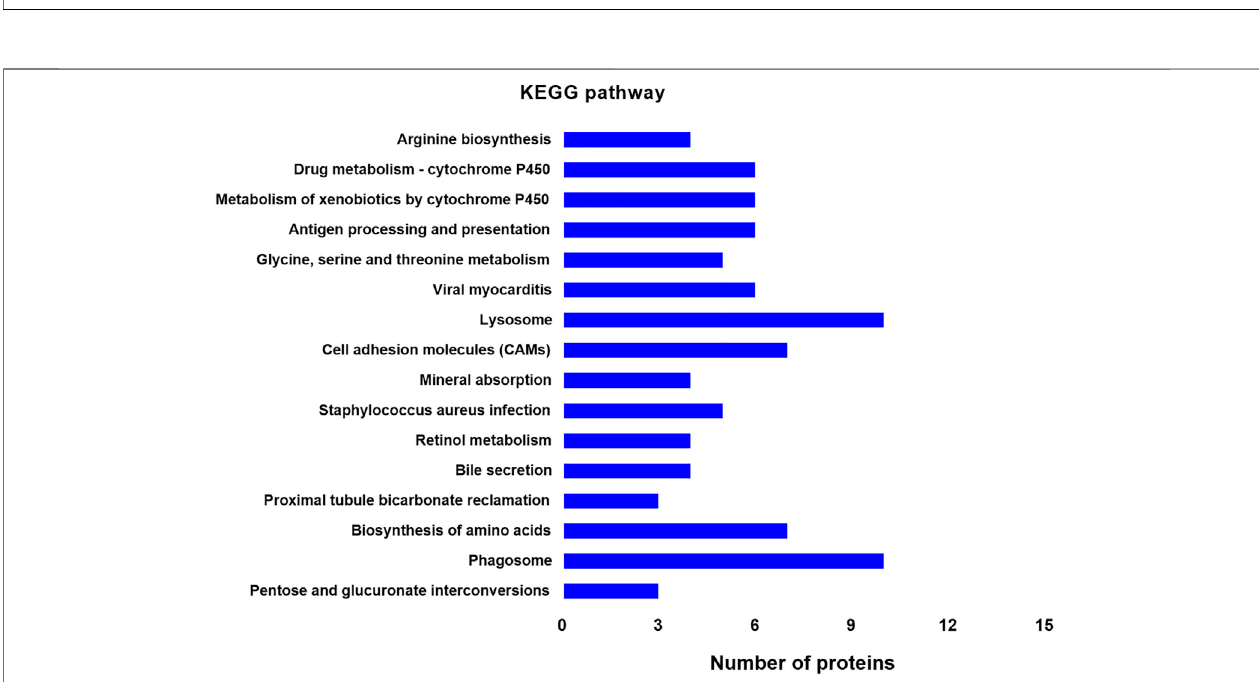
FIGURE 6 | Distribution of enriched KEGG pathways between the BLM + TL group and BLM group. The vertical axis indicates the KEGG pathway. The horizontal axispresentsthenumberofproteins.The p -valuesofenrichmentanalysisgraduallydecreasesfromtoptobottom.Argininebiosynthesisshowsthehighestsigni fi cance.